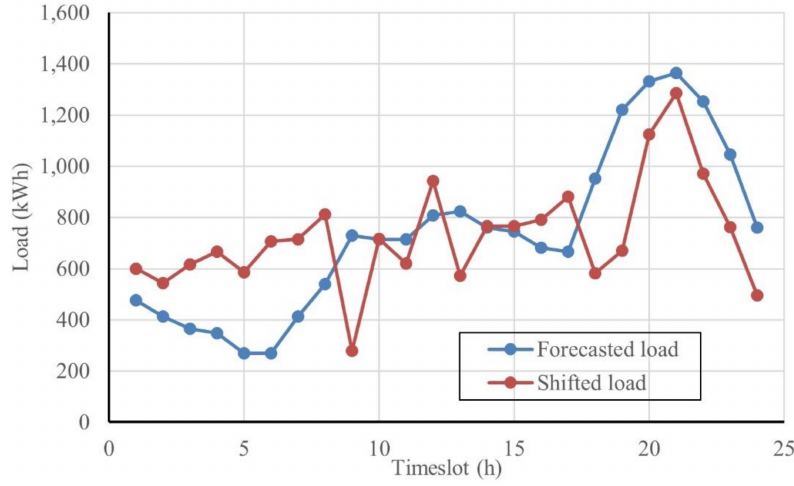
Figure 20. Hourly residential load before and after DSM using the centralized algorithm RTP-SBY.